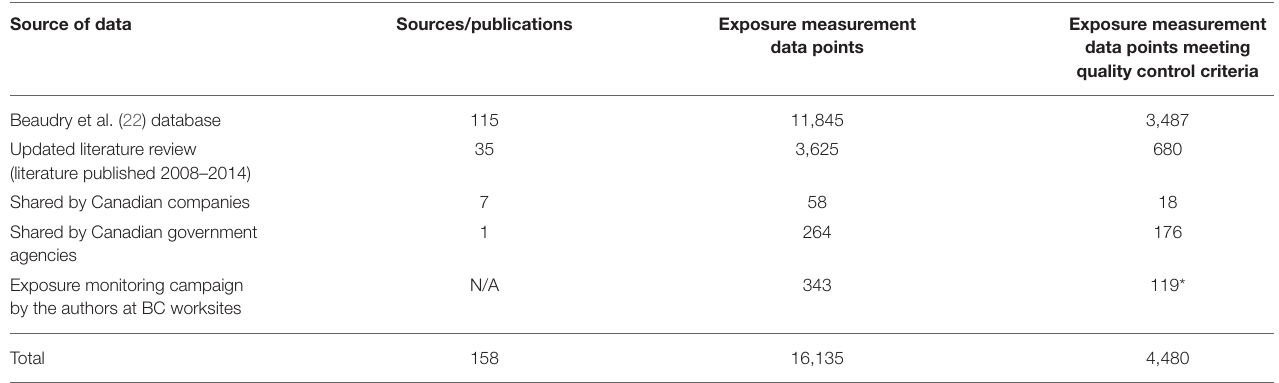
TABLE 1 | Number of sources of RCS exposure data and exposure data points in the final database used for analysis.